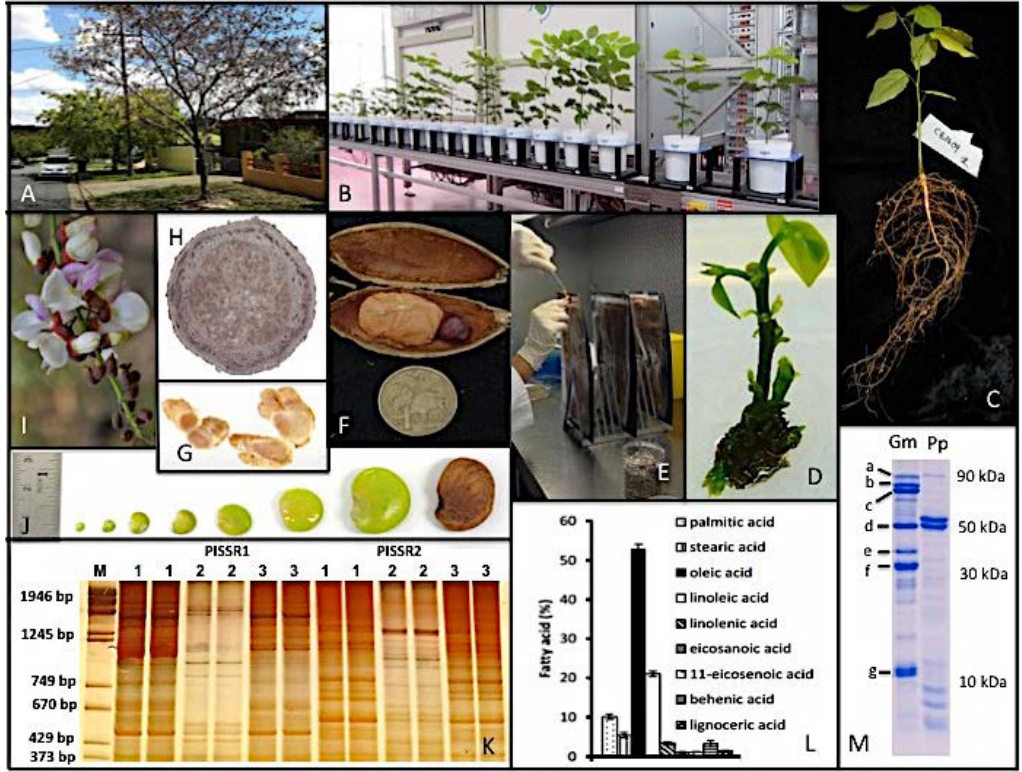
Figure 4. The biological properties of Pongamia, a biofuel feed stock tree with potential. ( A ) Street trees in Brisbane (Australia) during spring (late November). Note the variable spring leaf burst caused by genetic heterogeneity. Such variation is a problem for the producer, but a benefit to the experimenter; ( B ) Pongamia plants grown for analysis in the Adelaide Automated Growth Facility; ( C ) Pongamia seedling plant with nodules induced by Bradyrhizobium japonicum strain CB1809, a common Australian soybean inoculum; ( D ) Pongamia growing in tissue culture. Clonal regenerants from immature cotyledons are now growing in fields; ( E ) Pouch growth of Pongamia seedlings allows nodulation studies; ( F ) Pongamia pod and seed (about 20 mm long seed; about 2 g/seed). Pod casing potential can be co-fired for electricity formation; ( G ) Pongamia nitrogen-fixing root nodules (about 2–3 mm in length four weeks after inoculation); ( H ) Pongamia root nodule close-up (about 3 mm in diameter). Bacteria are housed as bacteroids in the interior; ( I ) Pongamia flowers (pea-like; about 6–8 mm in length); ( J ) Pongamia seed development: Takes 10–12 months from fertilisation to harvest of dry seed; ( K ) Pongamia genetic diversity testing. PISSR markers (Pongamia Interstitial Single Sequence Repeats) based genomic DNA sequence separated by polyacrylamide gels electrophoresis and silver stained (Bassam and Gresshoff, Nature Protocols, 2007); ( L ) Pongamia seed oil composition derived from one seed of tree HS-62; ( M ) Pongamia seed cake components stained for protein. Left lane: soybean (Gm); right: Pongamia (Pp). (a) lipoxygenase (90 kDa); (b) 7Sα prime (70 kDa); (c) 7Sα (66.4 kDa); (d) 7Sβ conglycinin (51 kDa); (e) 11SAβ (41 kDa); (f) 11SA1a, A1b, A2 (38.5 kDa); (g) sB1a, B1, B2, B3, 11SB4 (10 kDa). The genes for the main Pongamia pinnata seed storage proteins (50 and 52 kDa) were cloned and shown to be similar to the low quality seed storage protein 7S β